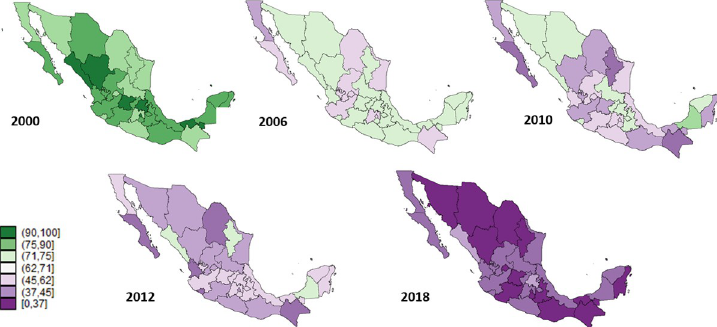
Fig 2. Estimated coverage of the complete basic scheme in the 6–11 months population, Mexico